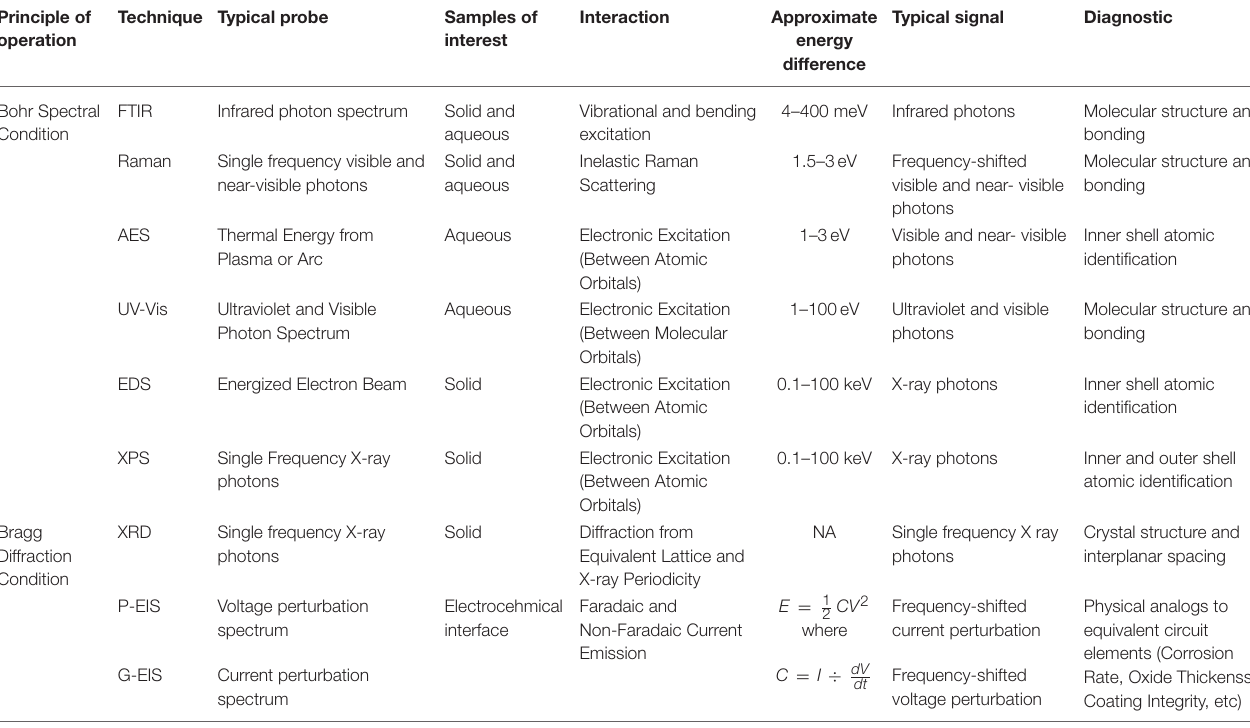
TABLE 2 | Table summarizing the various techniques discussed, as organized by principles of operation, detailing important characteristic of each. Principle of